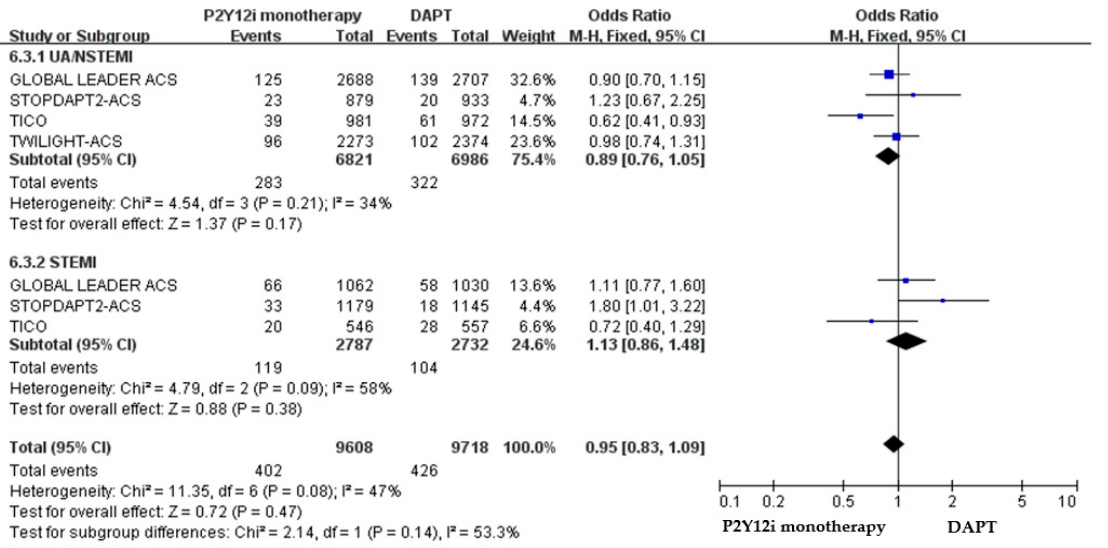
Figure 7. The efficacy outcomes (MACCE) of P2Y12 inhibitor monotherapy in STE-ACS patients and NSTE-ACS after PCI as compared with 12-month DAPT.